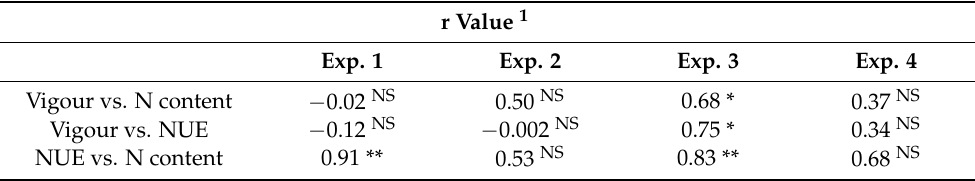
Table 4. Coefficients of linear correlations between cultivar vigour, N uptake efficiency and N content/plant.